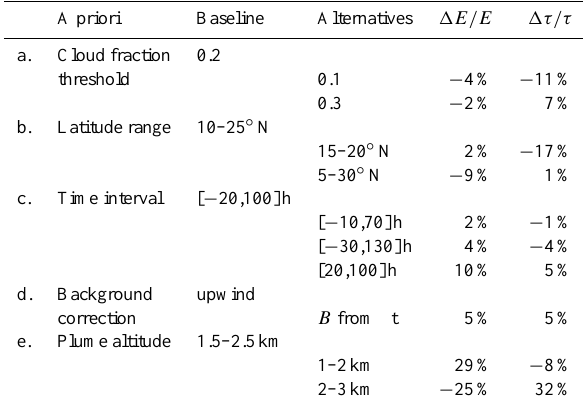
Table 2. Baseline and alternative a priori settings for the fitting pro- cedure and their impact on emission rate and lifetime estimates for March–November